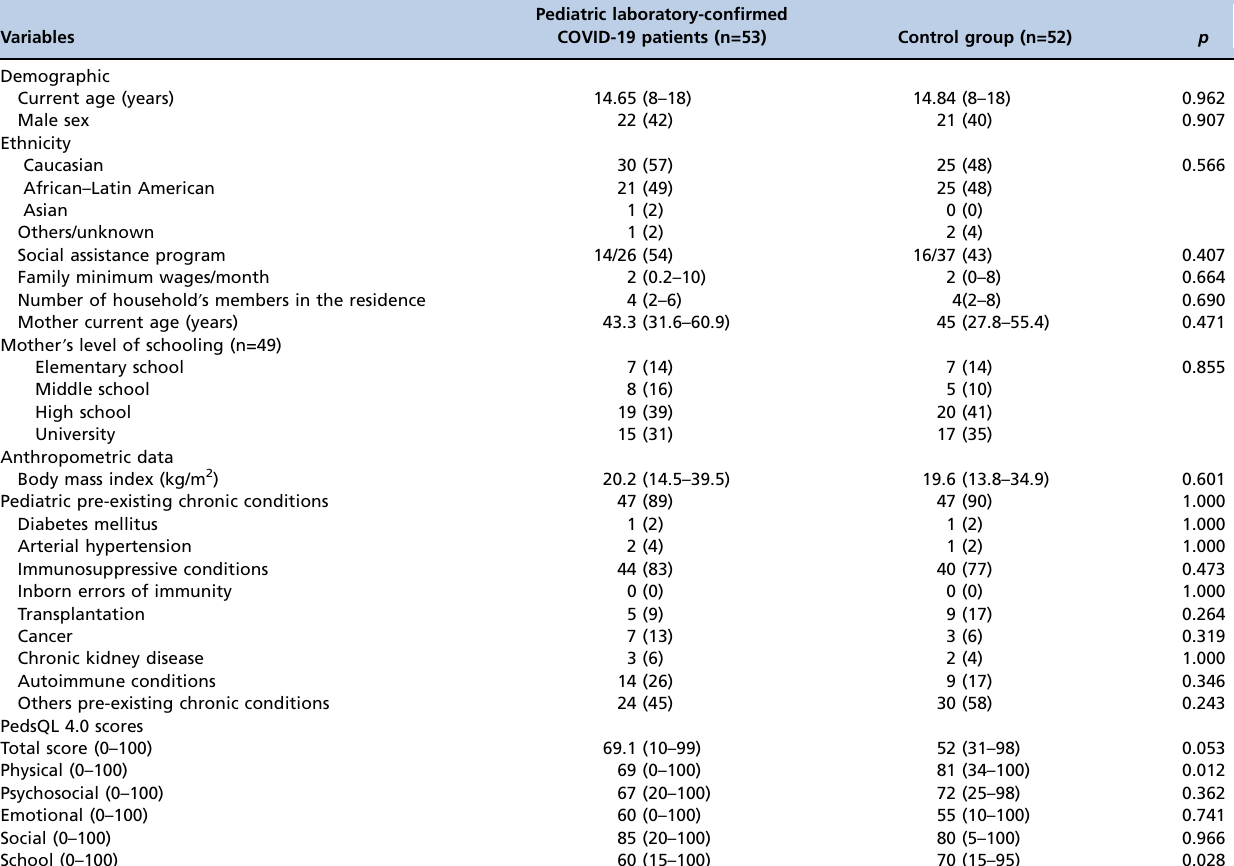
Table 3 - Demographic, anthropometric, and Pediatric Quality of Life Inventory 4.0 (PedsQL 4.0) scores in subjects with pediatric laboratory-confirmed coronavirus disease (COVID-19) at longitudinal follow-up visit and in controls (subjects without laboratory- confirmed